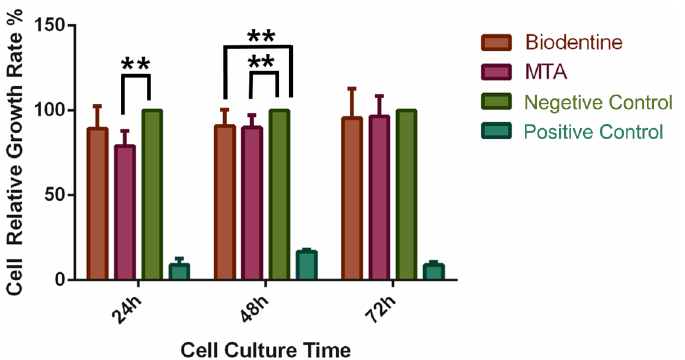
Figure 1- Effects of MTA and BD on human periodontal ligament cells (hPDLCs). hPDLCs were cultured with α-MEM containing MTA or BD in a 96-well plate for 24, 48, or 72 hours. The relative growth rate (RGR) was evaluated using a CCK-8 assay. The RGR of the negative control (NC) group was set to 100%, and other groups were compared to the NC group. **P <